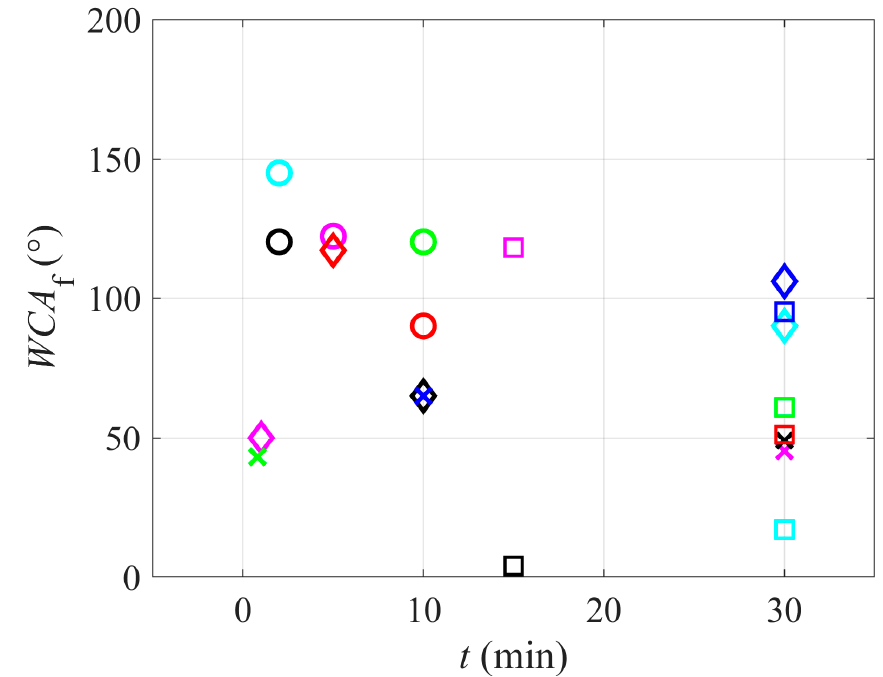
Figure 6. Water contact angle versus the treatment time.